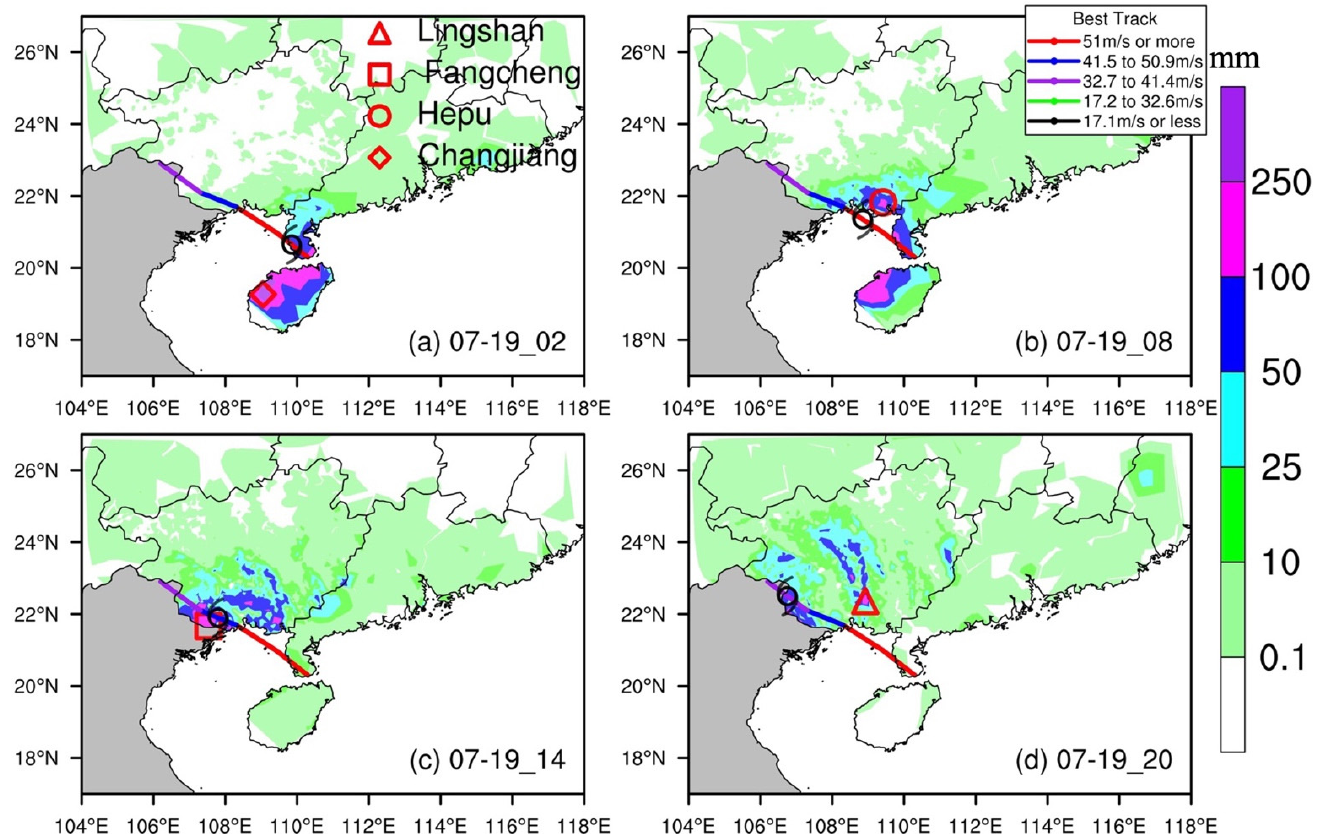
Figure 2. The geographic distribution of observed 6-hour precipitation and track and intensity changes of Rammasun from 20BST 18th to 20BST 19th July ( a – d ), with the red markers denoting location of maximum precipitation of the corresponding accumulated period (shown as the end time).